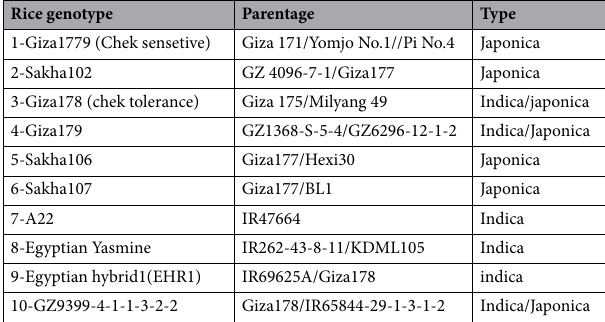
Table 2. Origin, parentage, and variety group of the studied